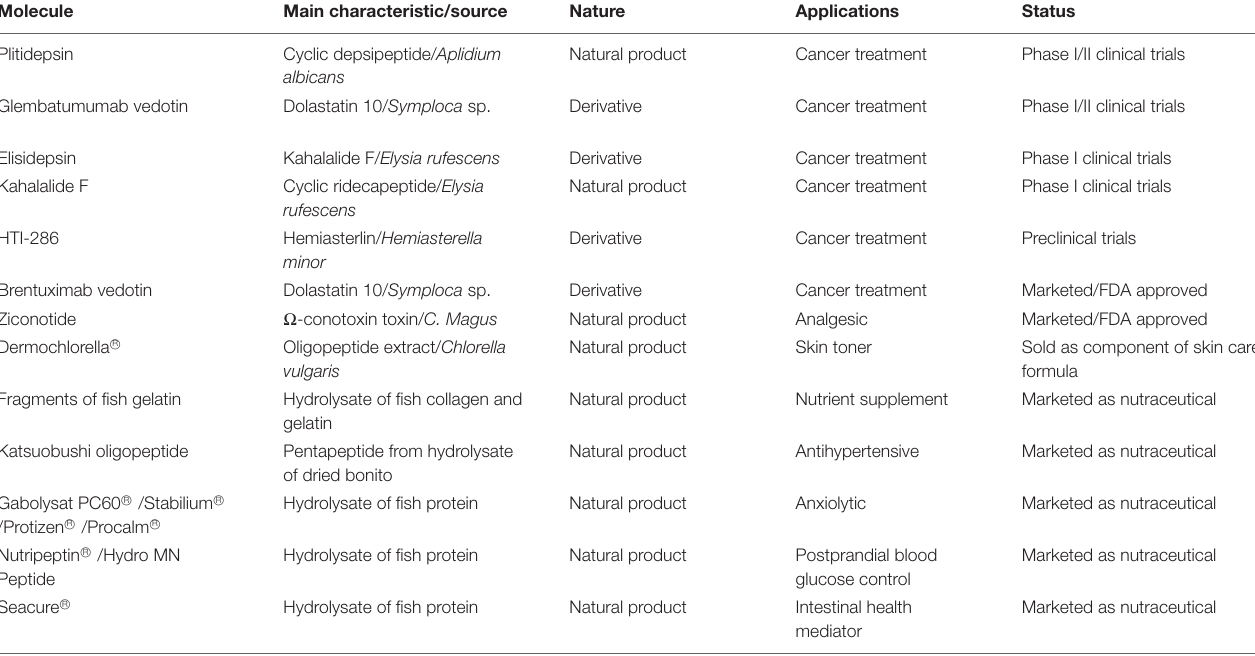
TABLE 2 | The current status of marine peptides on the market and under clinical